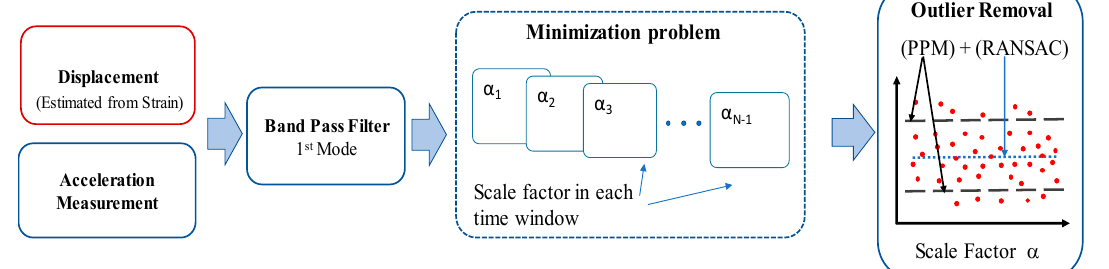
Figure 2. Overview of calibration factor estimation.